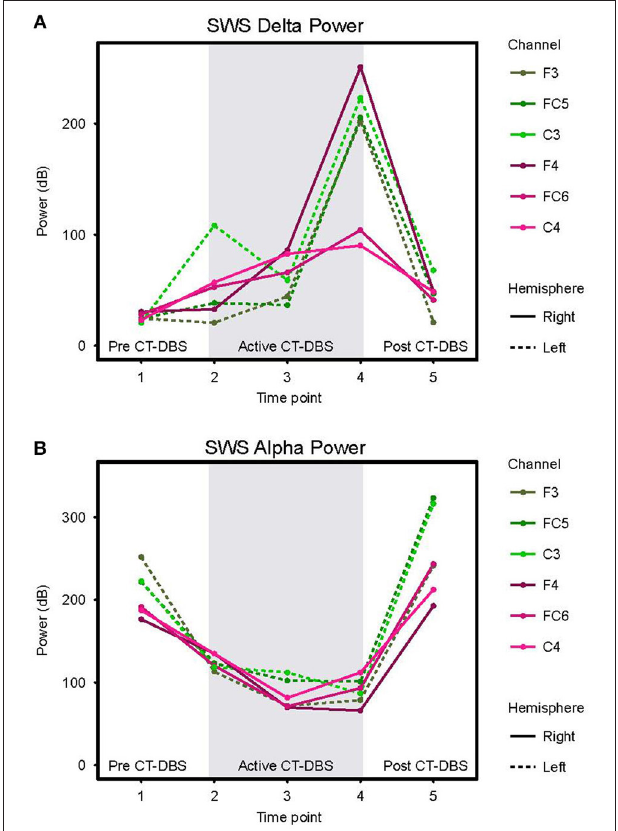
FIGURE 5 | Slow wave sleep dynamics. Power spectra were calculated for representative SWS segments (including alpha-delta sleep) and values normalized for comparison across time points. (A) SWS power in the 0.5–4Hz delta frequency range, plotted according to channel and time point. (B) SWS power in the 8–14Hz alpha frequency range, plotted according to channel and time point. Dotted lines represent left hemisphere channels and solid lines represent right hemisphere channels. Individual channels are plotted by color. Gray shading indicates active CT-DBS time points.